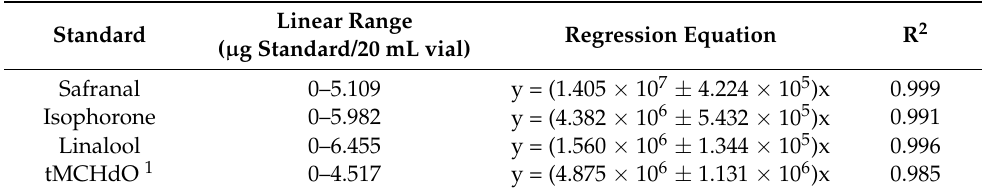
Table 1. Linearity data for analysis by headspace-stir bar sorptive extraction-gas chromatography/mass spectrometry.